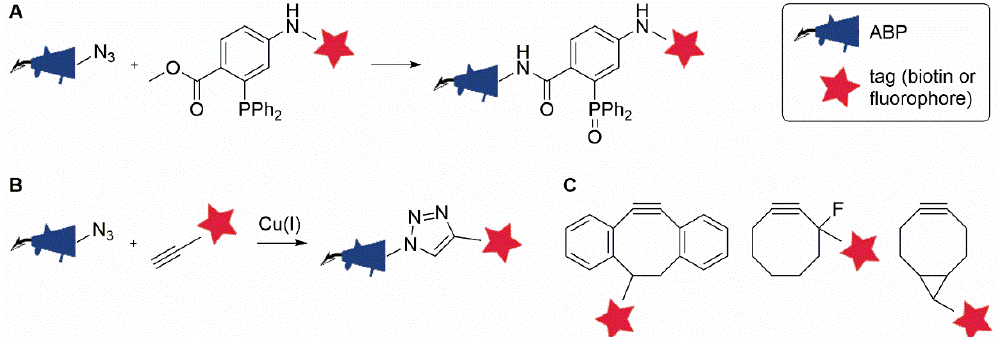
Figure 3. Azide-based bioorthogonal ligation reactions that have been used in combination with ABPP. ( A ) Staudinger–Bertozzi ligation between an azide and a phosphine. ( B ) Copper(I)-catalyzed azide-alkyne cycloaddition (CuAAC, or ‘click’ reaction). ( C ) Strained alkynes for use in copper-free strain-promoted azide-alkyne cycloaddition (SPAAC).